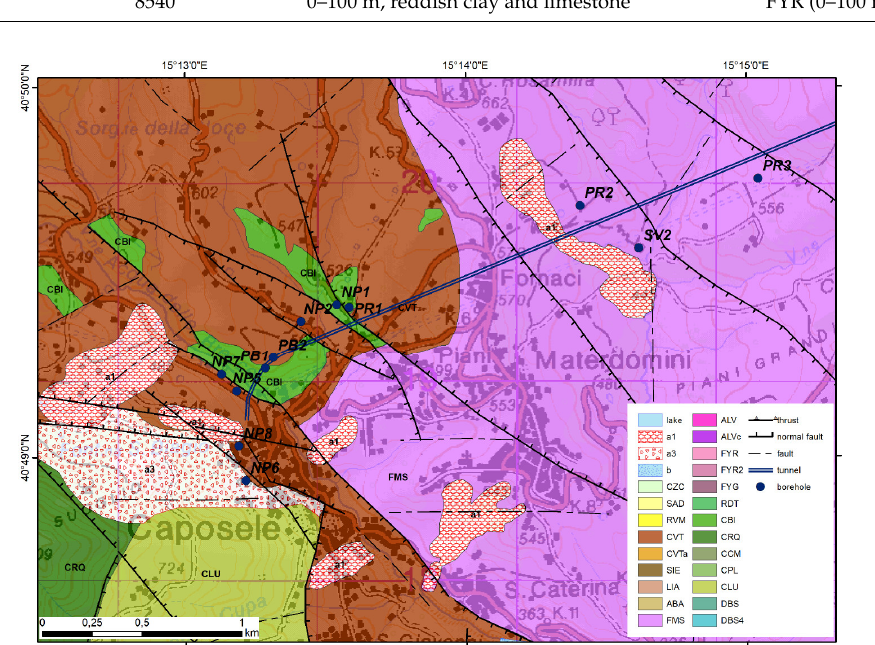
Figure 7. Detail of the Geological map of the Caposele sector of study area with borehole location. For legend unit codes, see Figure 4 caption. Table 2. Borehole stratigraphy data available in the study area. For unit codes see Table 1 caption.